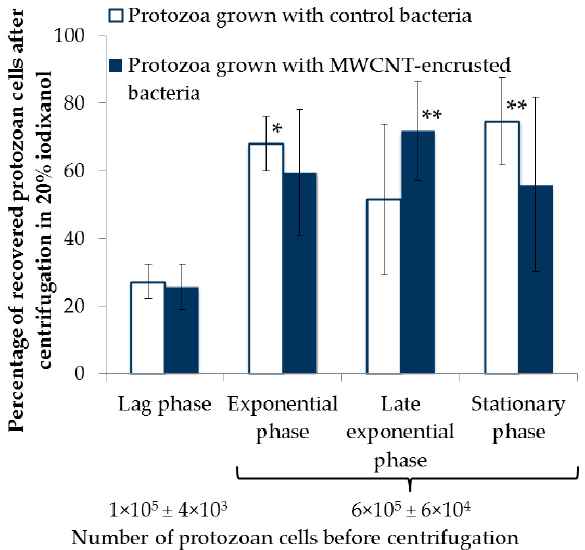
Figure 5. Protozoan cell recovery percentages after density gradient centrifugation steps in iodixanol when sampled at four different protozoan growth phases. Protozoa were grown with control (untreated, white bars) or MWCNT ‐ treated bacteria (blue bars). Data bars represent the mean values of three measurements and error bars are standard deviations. The values of “Number of protozoan cells before centrifugation” denote the total protozoan cell number in the concentrated samples after differential centrifugation but before density gradient centrifugation in iodixanol. Asterisks indicate significant difference from the recovery percentage at lag phase, both in control and MWCNT ‐ amended exposure, using Tukey’s multiple comparisons test across all eight conditions, p ≤ 0.05 (**) and p ≤ 0.1 (*). There was no significant difference between the percentages of recovered protozoan cells grown with control bacteria (white bars) versus protozoan cells grown with MWCNT ‐ encrusted bacteria (blue bars) within each growth phase.